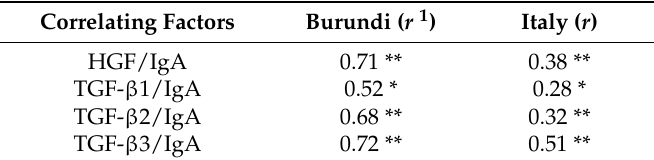
Table 3. Correlation between levels of growth factors (TGF β 1, 2, and 3) with IgA. Correlating